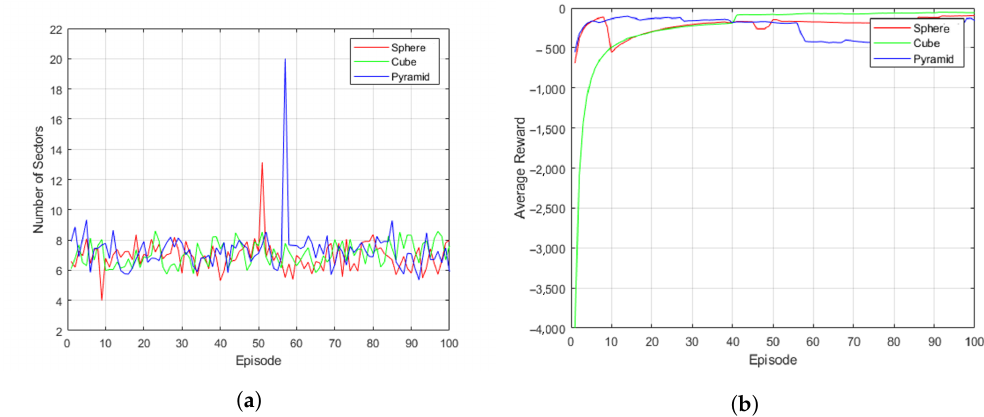
Figure 4. Simulation results of typical UAV formation (spheres, cubes, pyramids): ( a ) Subspace Change. ( b ) Episodic